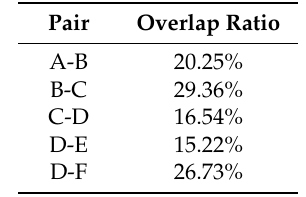
Table 1. Overlapping ratios of dataset scans.